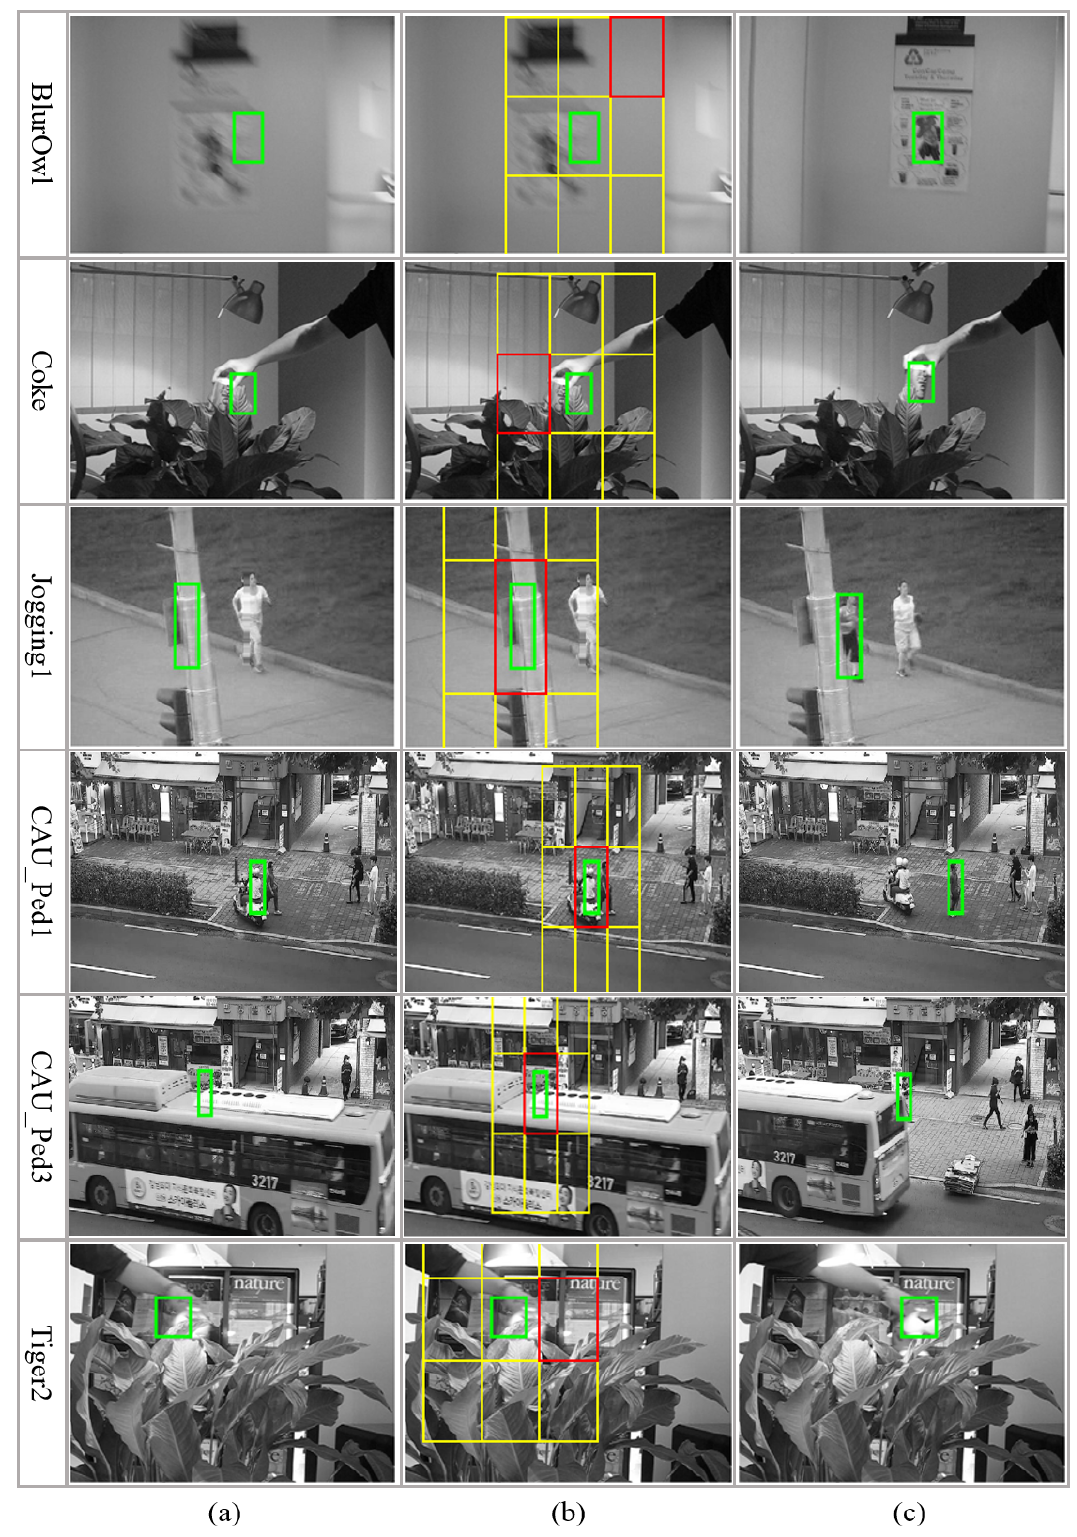
Figure 12. Target re-capturing process. ( a ) Tracking failure detected. ( b ) Tracking failure handling. ( c ) Target